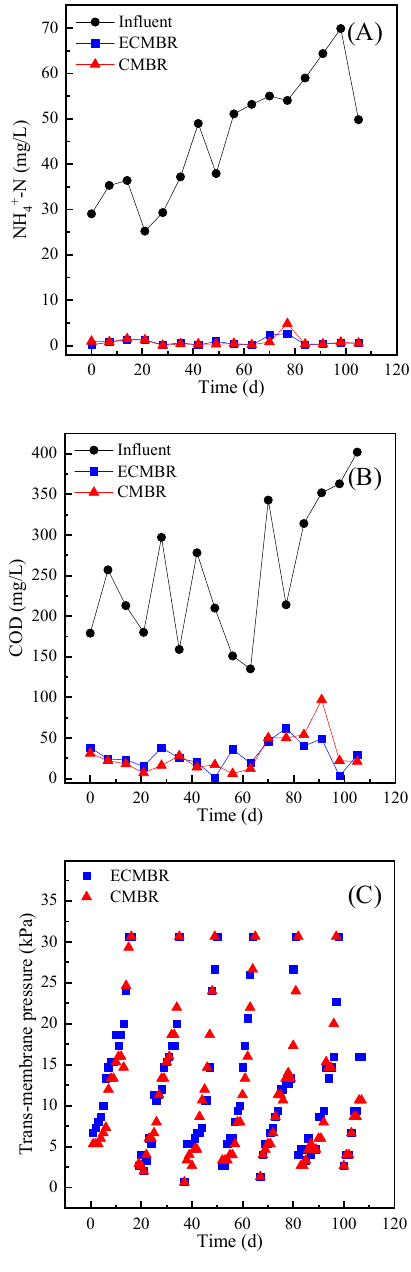
Figure 3. Performance of the MBR systems. ( A ) NH 4 + -N and ( B ) COD removal in ECMBR and conventional MBR (CMBR); ( C ) the evolution of trans-membrane pressure in the two MBRs.